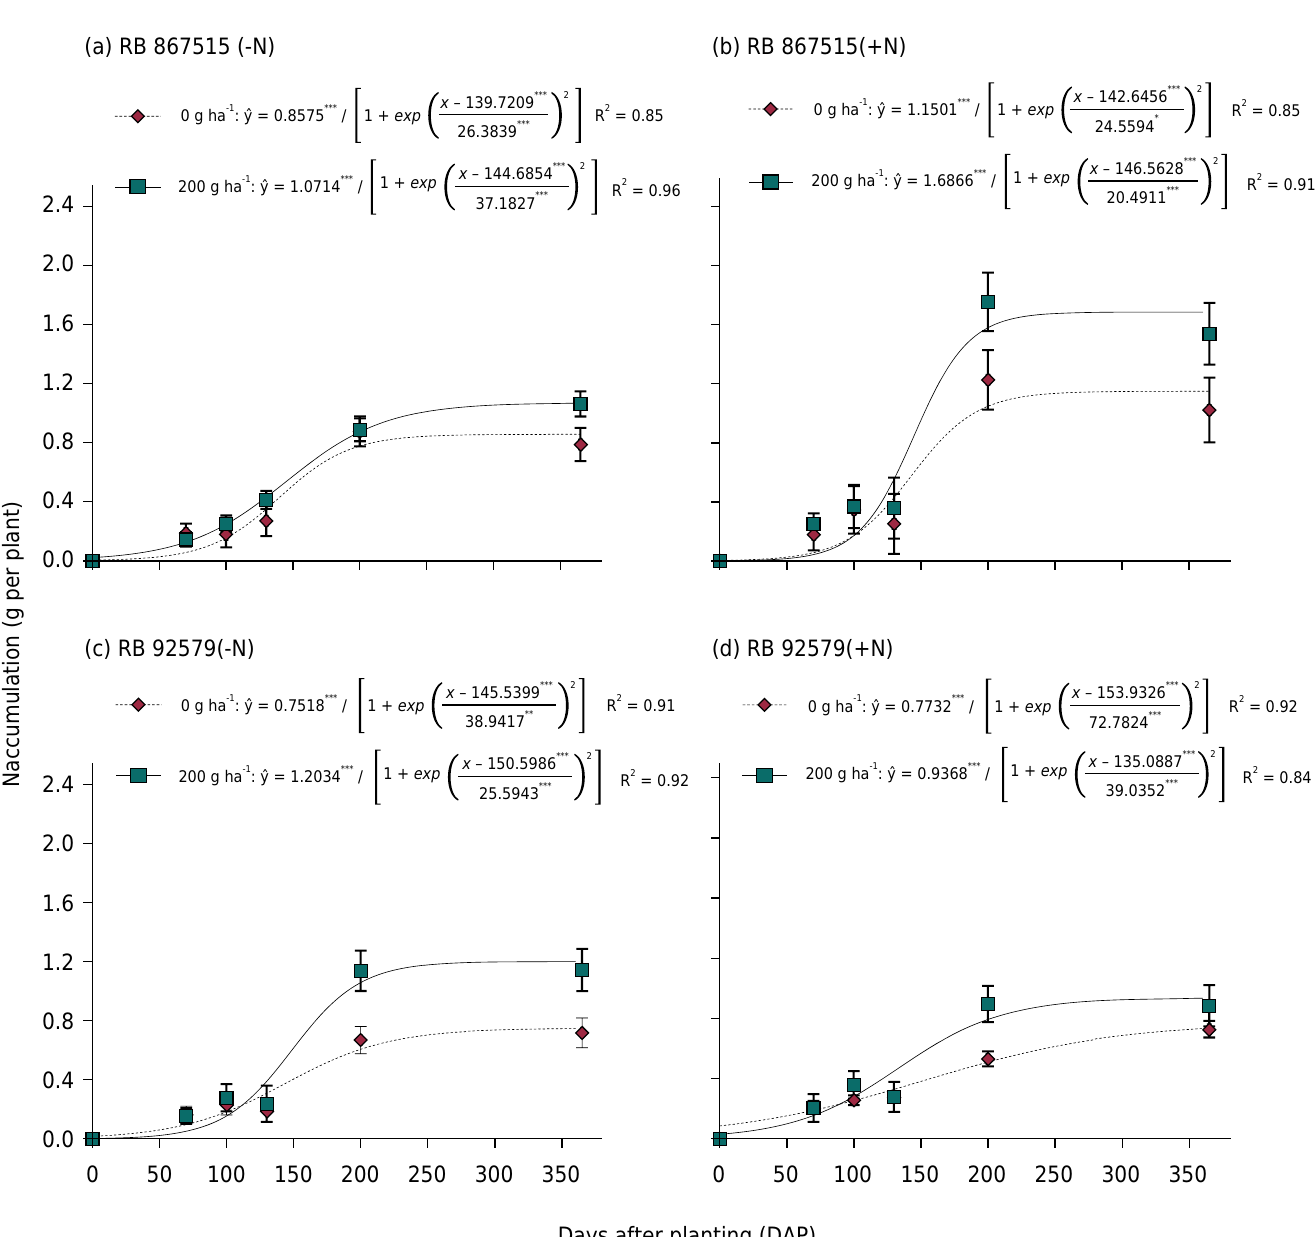
Figure 3. Nitrogen accumulation in the shoots of sugarcane -Mo and +Mo (200 g ha -1 ) fertilization for the variety RB 867515, -N and +N (60 kg ha -1 ) fertilization (a and b, respectively), and for the variety RB 92579, -N and +N fertilization (c and d, respectively) at 70, 100, 130, 200, and 365 days after planting